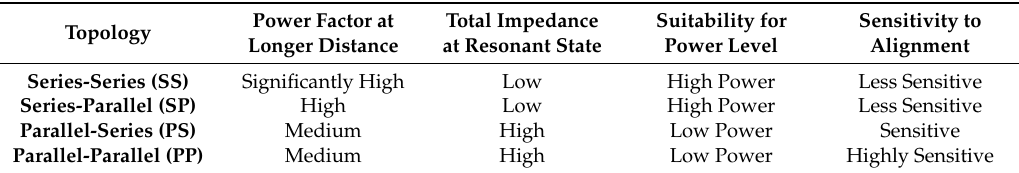
Table 1. Characteristics of compensation